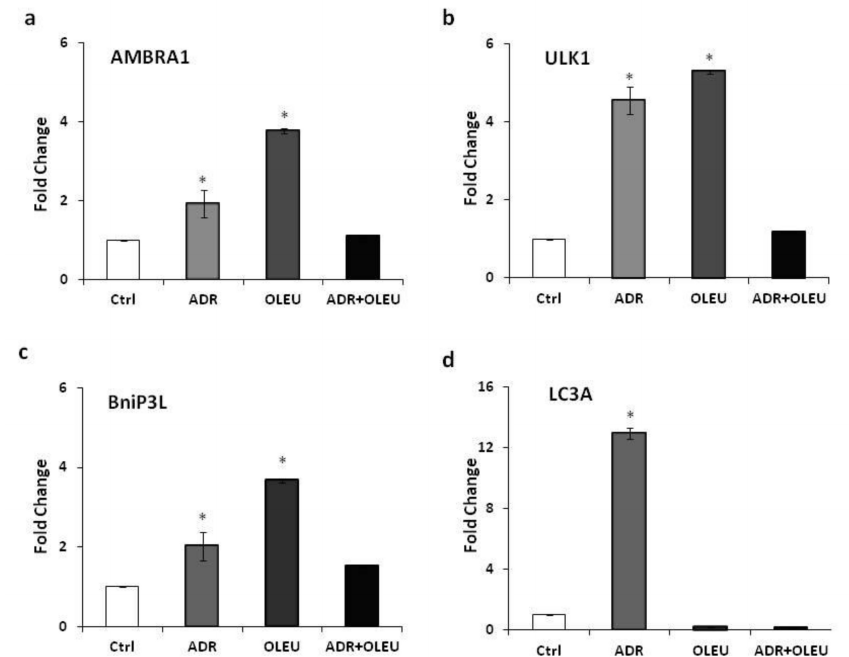
Figure 3. Expression levels of autophagy-related genes ( a ) AMBRA1, ( b ) ULK1, ( c ) BNiP3L, ( d ) LC3A, in MG-63 cells after ADR, OLEU, ADR + OLEU treatments, as determined by qRT-PCR. mRNA ratios are normalized to ATPase. * p < 0.05 compared to control cells. AMBRA1: Activating Molecule in BECN1-Regulated Autophagy Protein 1; ULK1: Unc-51 Like Au Table 1. BNiP3L; BCL2 Interacting Protein 3 Like; LC3A: microtubule-associated protein 1A light chain 3; white: control,